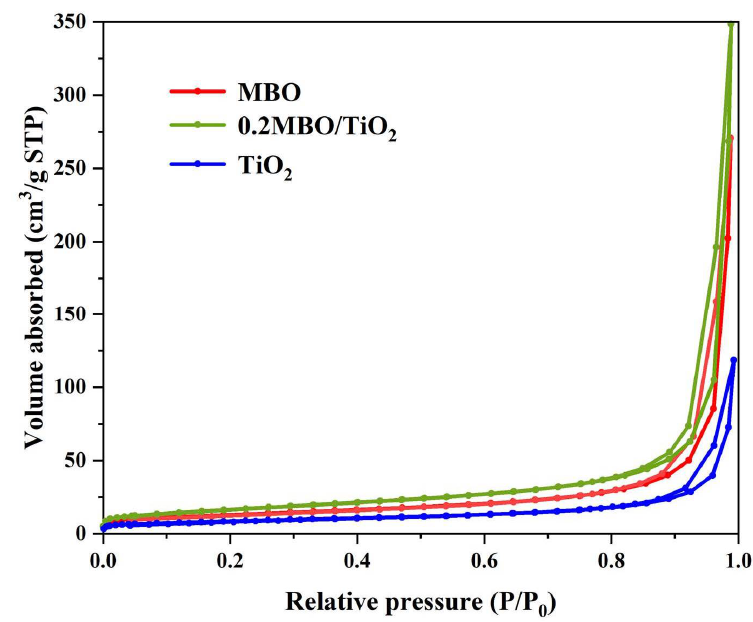
Figure 4. N 2 isothermal adsorption and desorption test curves of MBO, 0.2 MBO/TiO 2 and TiO 2 .